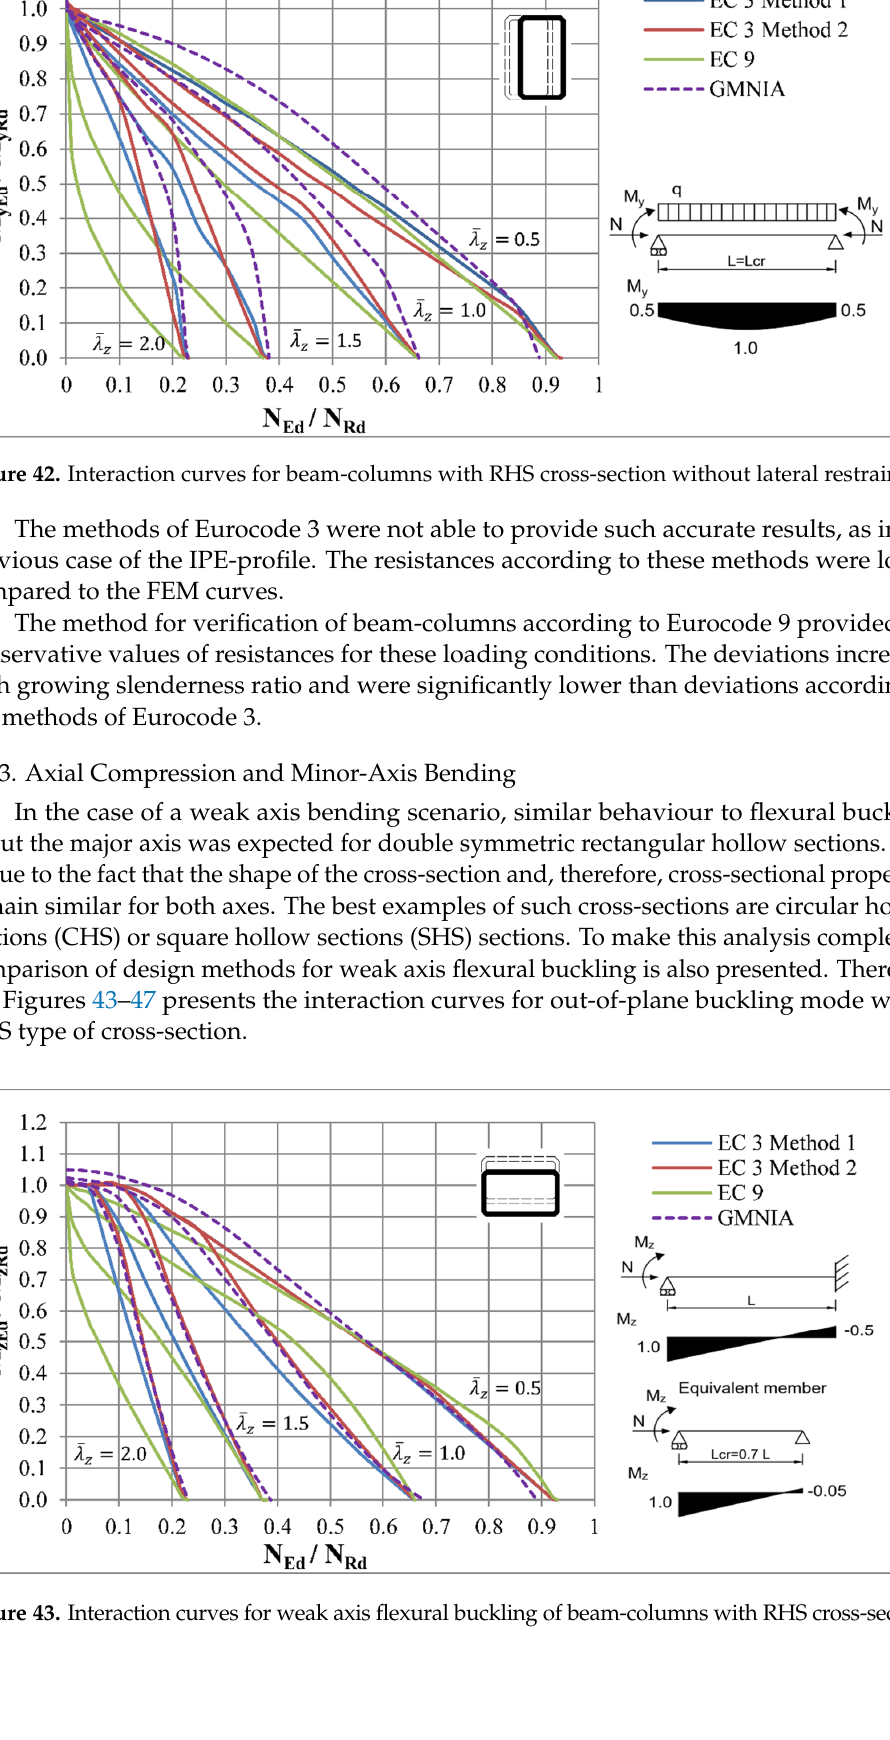
Figure 41. Interaction curves for beam-columns with RHS cross-section without lateral restraints.